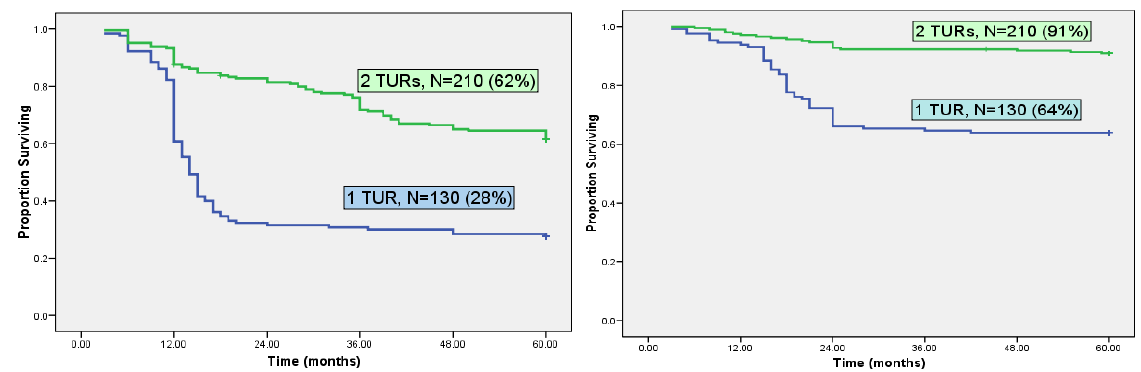
FIGURE 2. Recurrence-free (left) and progression-free (right) survival in 340 NMIBC patients treated with BCG after one vs. two